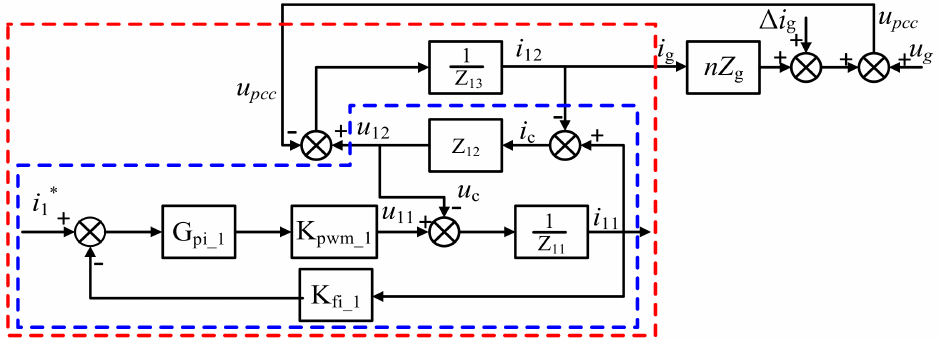
Figure 6. Equivalent block diagram of a single inverter when multiple inverters are connected to the